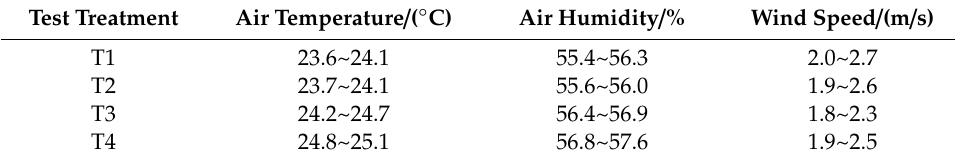
Table 1. The environmental conditions during the aerial spraying